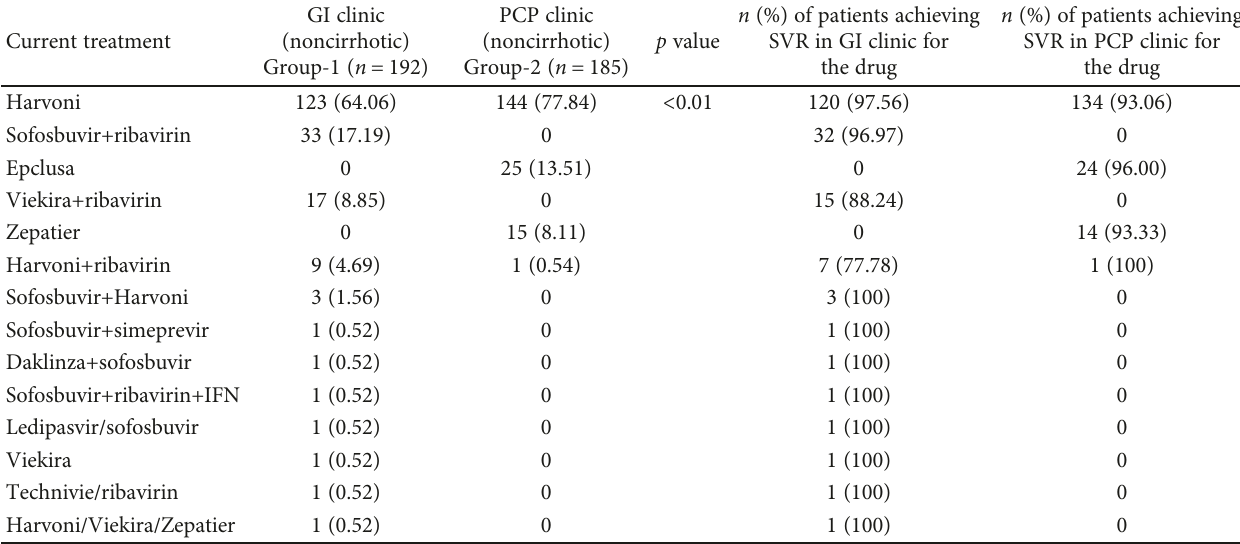
Table 4: SVR outcomes based on the prescribed anti-HCV